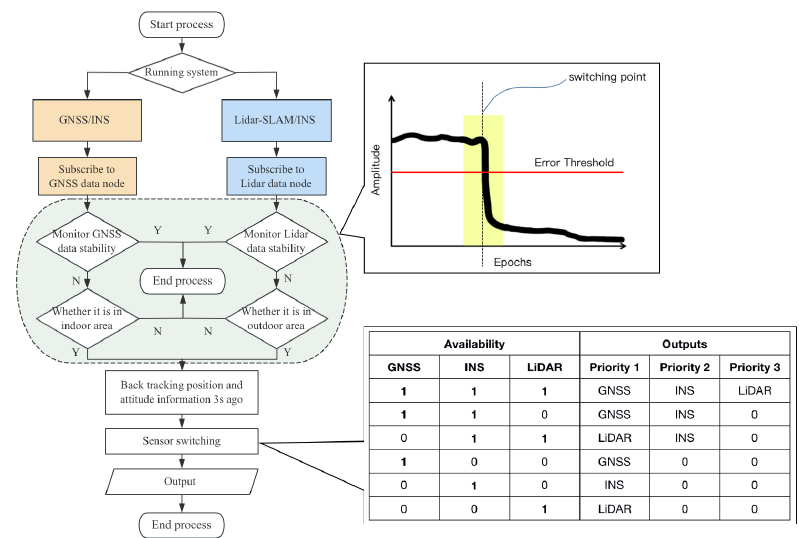
Figure 5. Dynamic sensor switching process of NavUSV.